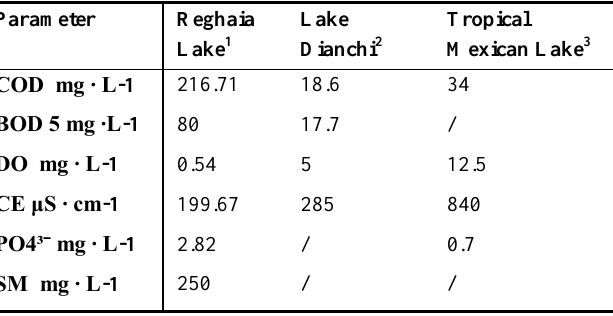
7. Comparison of results obtained from physicochemical characteristics with other